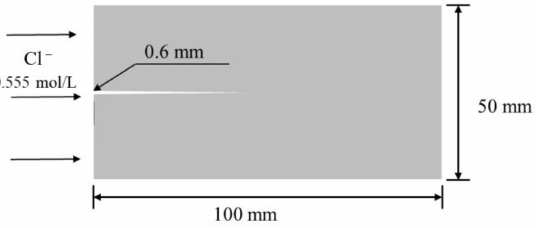
Figure 2. Illustration of the simulation settings for the non-steady-state chloride diffusion simulation in cracked concrete.